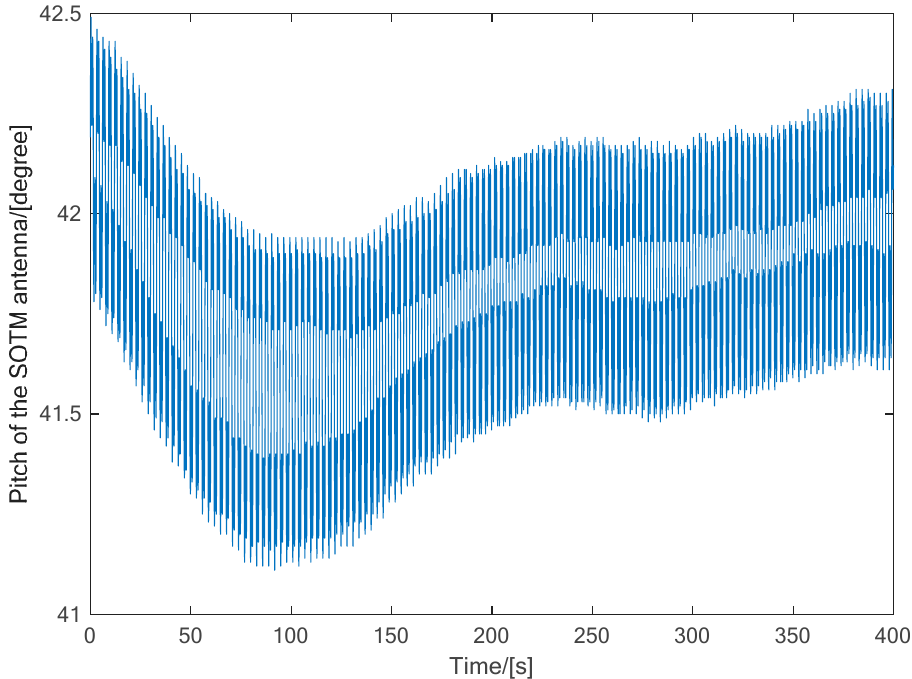
Figure 13. Pitch angle of the SOTM antenna of the conventional method.